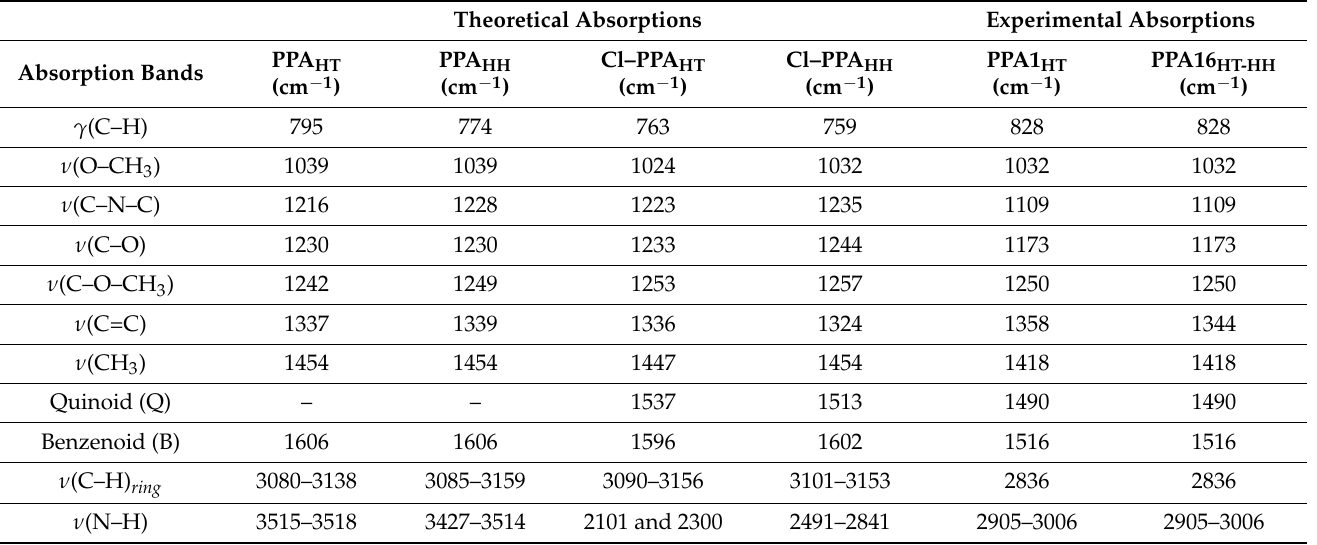
Table 4. Experimental and calculated absorption bands in the FTIR spectra of PPA HT , PPA HH